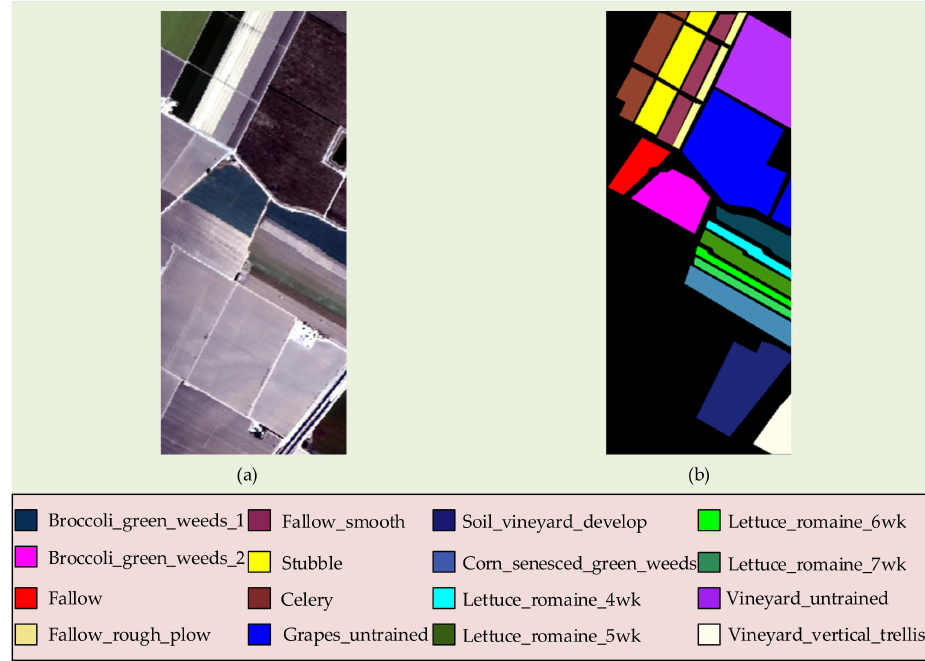
Figure 2. ( a ) original Salinas image; ( b ) ground reference map of